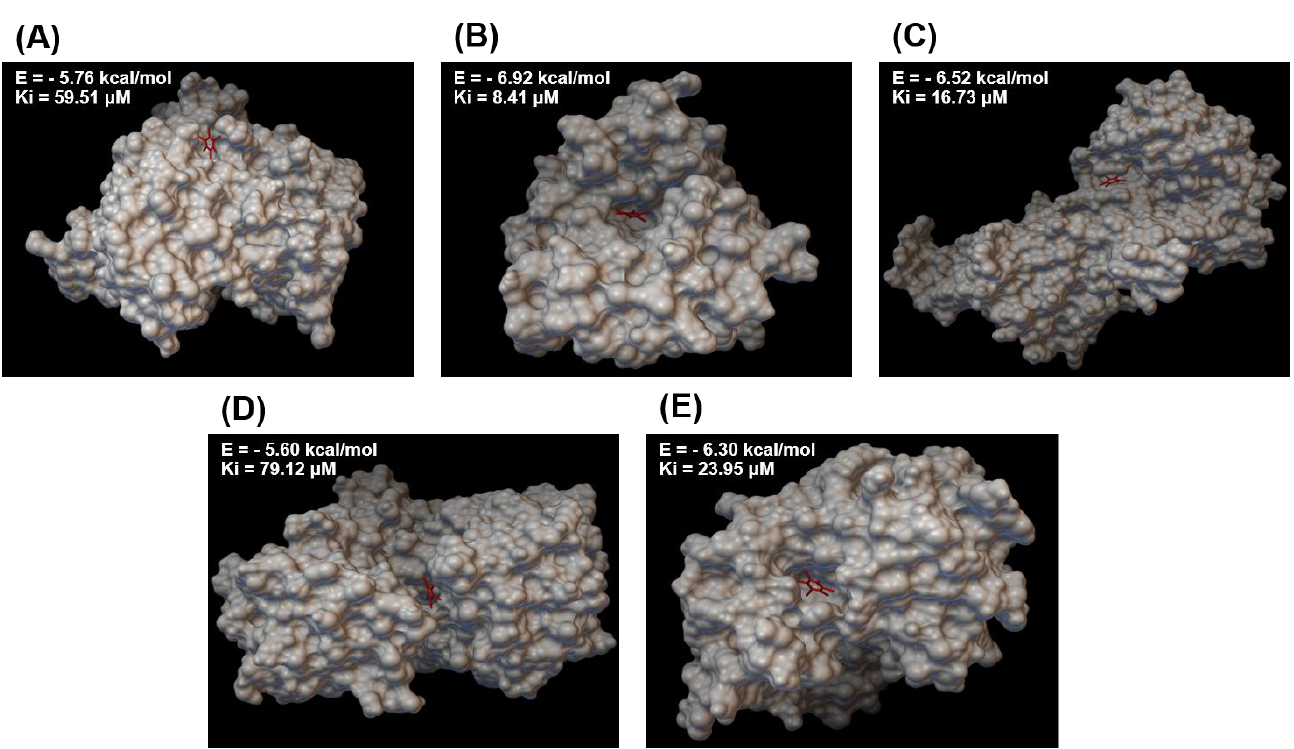
Figure 5. Overlay of HBB on five metabolite biomarker-related enzymes. HBB (red stick) is shown superimposed on a surface drawing of ( A ) GPT, ( B ) PAH, ( C ) RK, ( D ) CAH, and ( E ) BCAT. E, binding energy (kcal/mol); Ki, inhibition constant (µM).